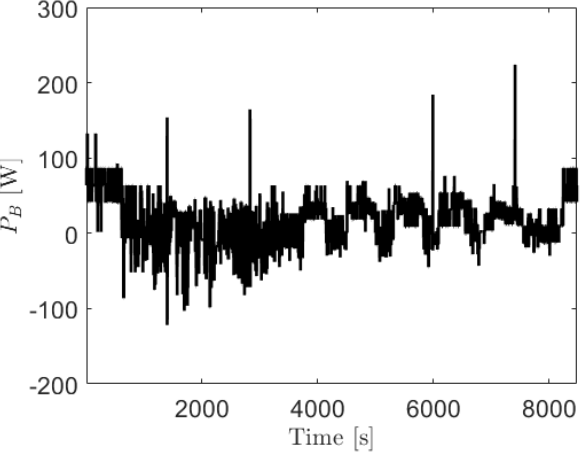
Figure 18. Battery power, Simulation Scenario